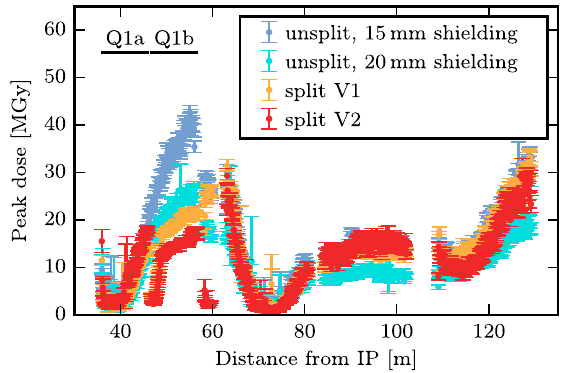
FIG. 17. Peak doses of the triplet with unsplit and split Q1. For an optimized Q1 split (V2), the maximum peak dose is reduced by about 33% with respect to the unsplit 20 mm shielding case.